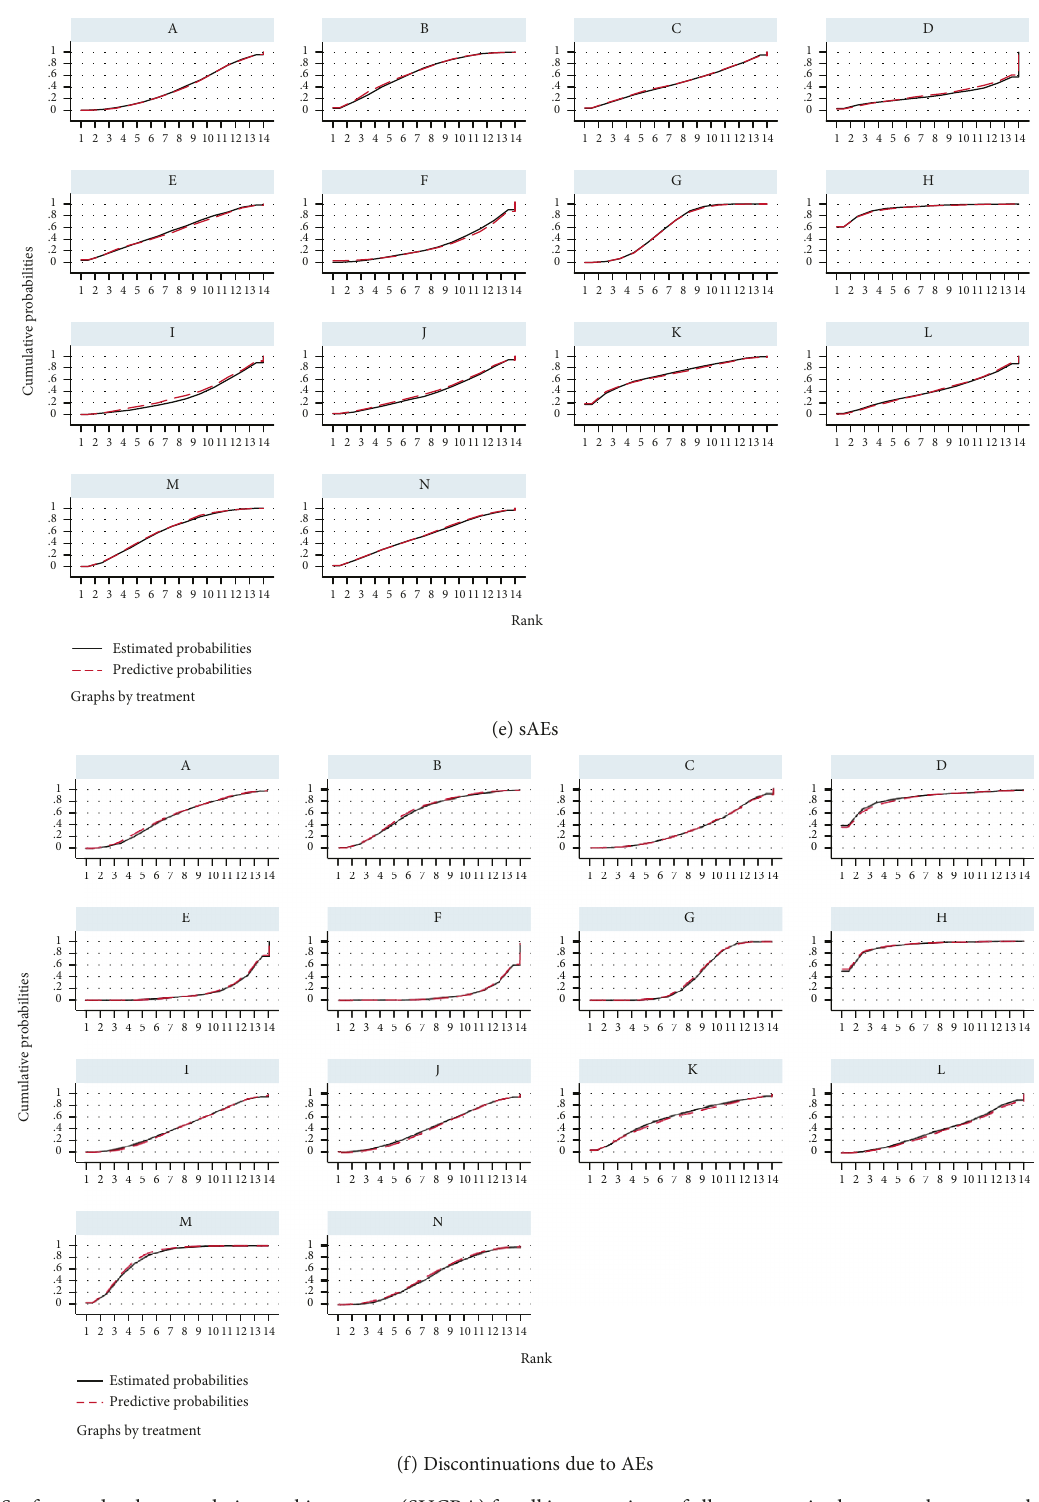
Figure 10: Surface under the cumulative ranking curves (SUCRA) for all interventions of all outcomes in the network meta-analysis. PASI 75: the percentages of patients with a 75% improvement from baseline in the PASI score; PASI 100: the percentages of patients with a 100% improvement from baseline in the PASI score; sPGA 0/1: static physician ’ s global assessment score of 0 or 1; IGA 0/1: a response of 0 or 1 on the modi fi ed investigator ’ s global assessment; PGA 0/1: physician ’ s global assessment score of 0 or 1; AEs: adverse events; sAEs: serious adverse events. Alphabetic reference: A, brodalumab 140mg; B, brodalumab 210mg, C, guselkumab 100 mg; D, guselkumab 50mg; E, ixekizumab 80mg Q2W; F, ixekizumab 80 mg Q4W; G, placebo; H, risankizumab 150 mg; I, secukinumab 150 mg; J, secukinumab 300mg; K, tildrakizumab 100mg; L, tildrakizumab 200mg; M, ustekinumab 45mg; and N, ustekinumab 90